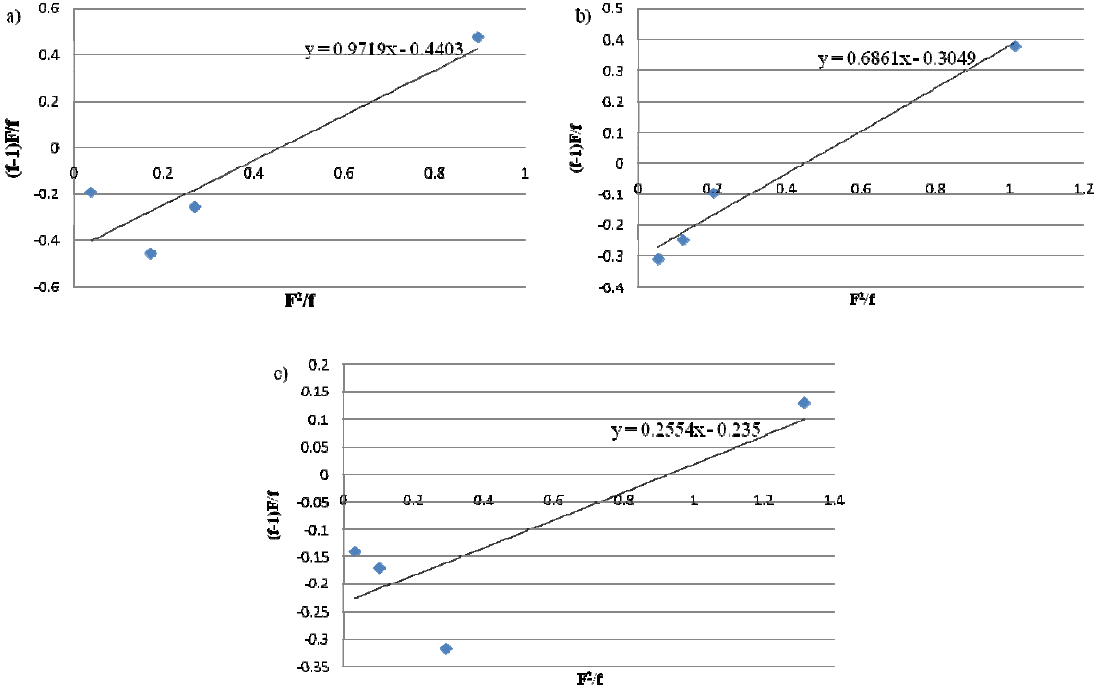
Figure 1. Fineman-Ross plots for the copolymers obtained with a ) complex1 b ) complex2 and c ) complex3 where F = the mole ratio of ethylene and 1-hexene in the feed and f = the